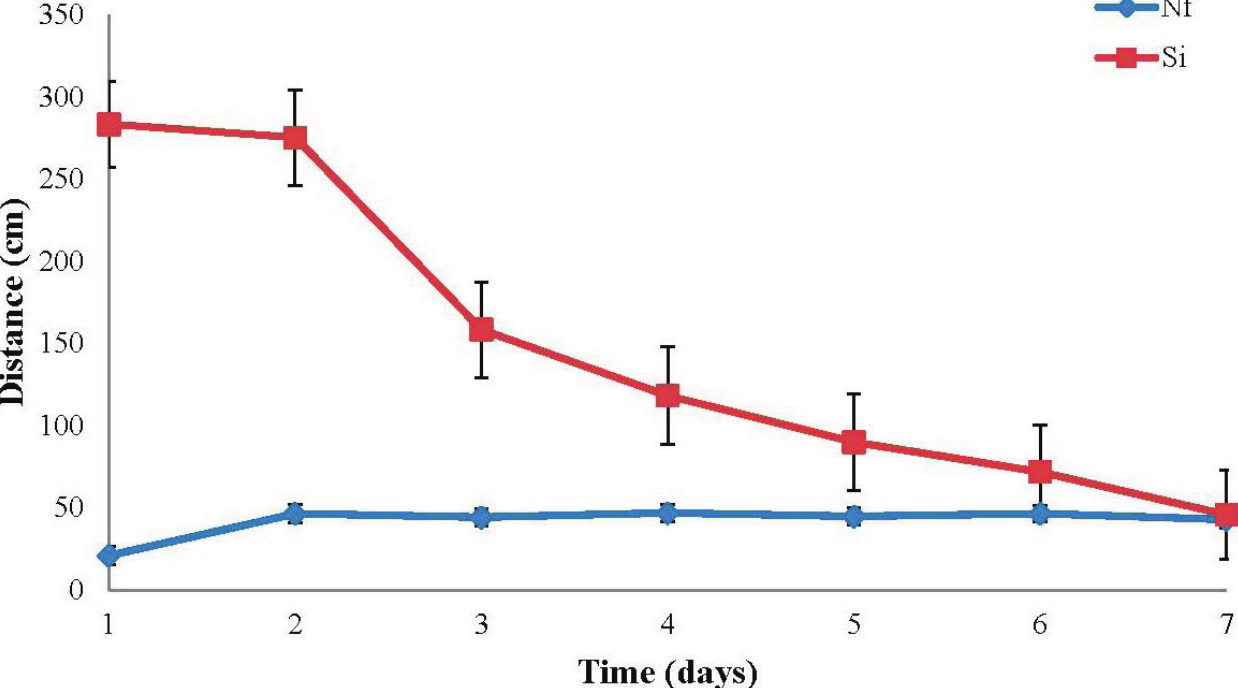
Figure 3. Mean (±SE) daily tunneling distances (cm) for Nylanderia fulva (Nf) and Solenopsis invicta (Si) over all